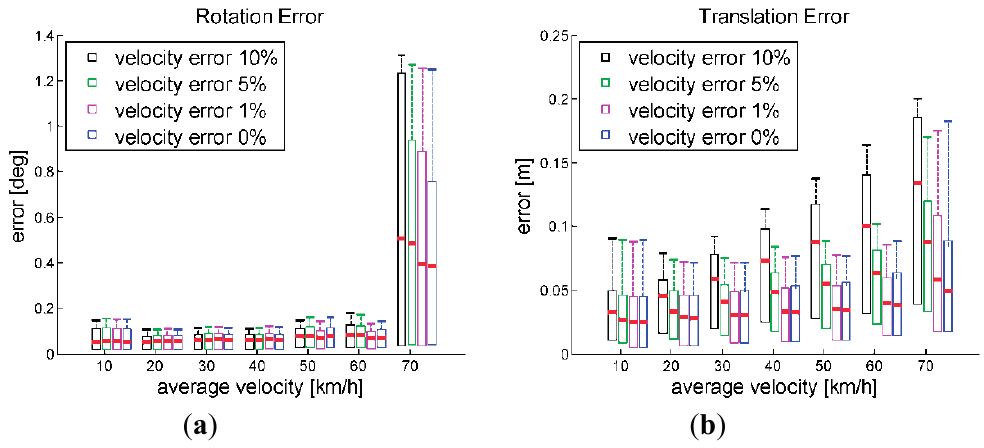
Figure 13. Rotation and translation error vs. vehicle velocity. Outlier percentage is set to 50%, velocity error varies from 0 to 10%.